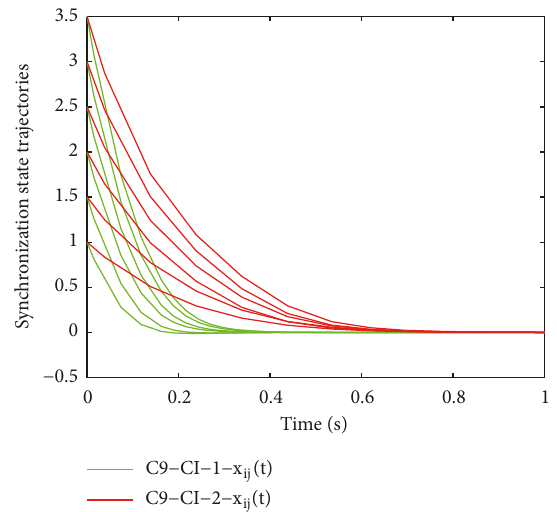
Figure 11: Synchronization state trajectories of the network (36) for the case I-1 and I-2 of Corollary 29.